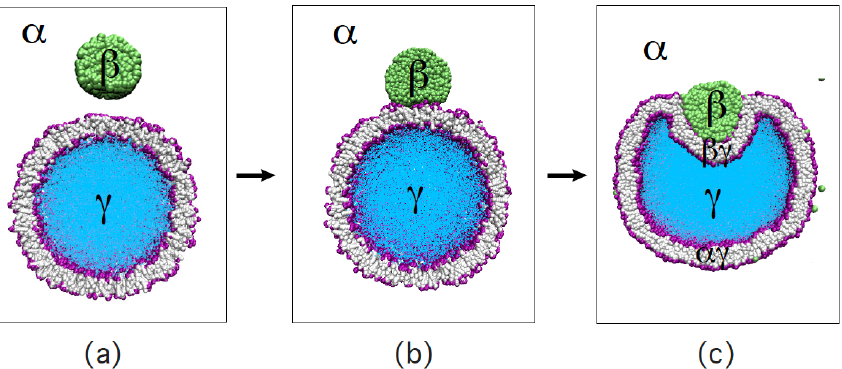
Figure 23. Partial engulfment of a condensate droplet (green) by the lipid bilayer (purple-grey) of a nanovesicle, as observed in molecular dynamics simulations [30]. The vesicle encloses the aqueous solution γ (blue). Both the nanodroplet and the nanovesicle are immersed in the aqueous bulk phase α (white): ( a ) Initially, the droplet is well separated from the vesicle which implies that the outer leaflet of the bilayer is only in contact with the α phase; ( b ) When the droplet is attracted towards the vesicle, it spreads onto the lipid bilayer, thereby forming an increasing contact area with the vesicle membrane; and ( c ) Partial engulfment of the droplet by the membrane after the vesicle-droplet couple has relaxed to a new stable state. The contact area between bilayer and β droplet defines the βγ segment of the bilayer membrane whereas the rest of the bilayer represents the αγ segment still in contact with the α phase. Vesicle and droplet have a diameter of 37nm and 11.2nm,